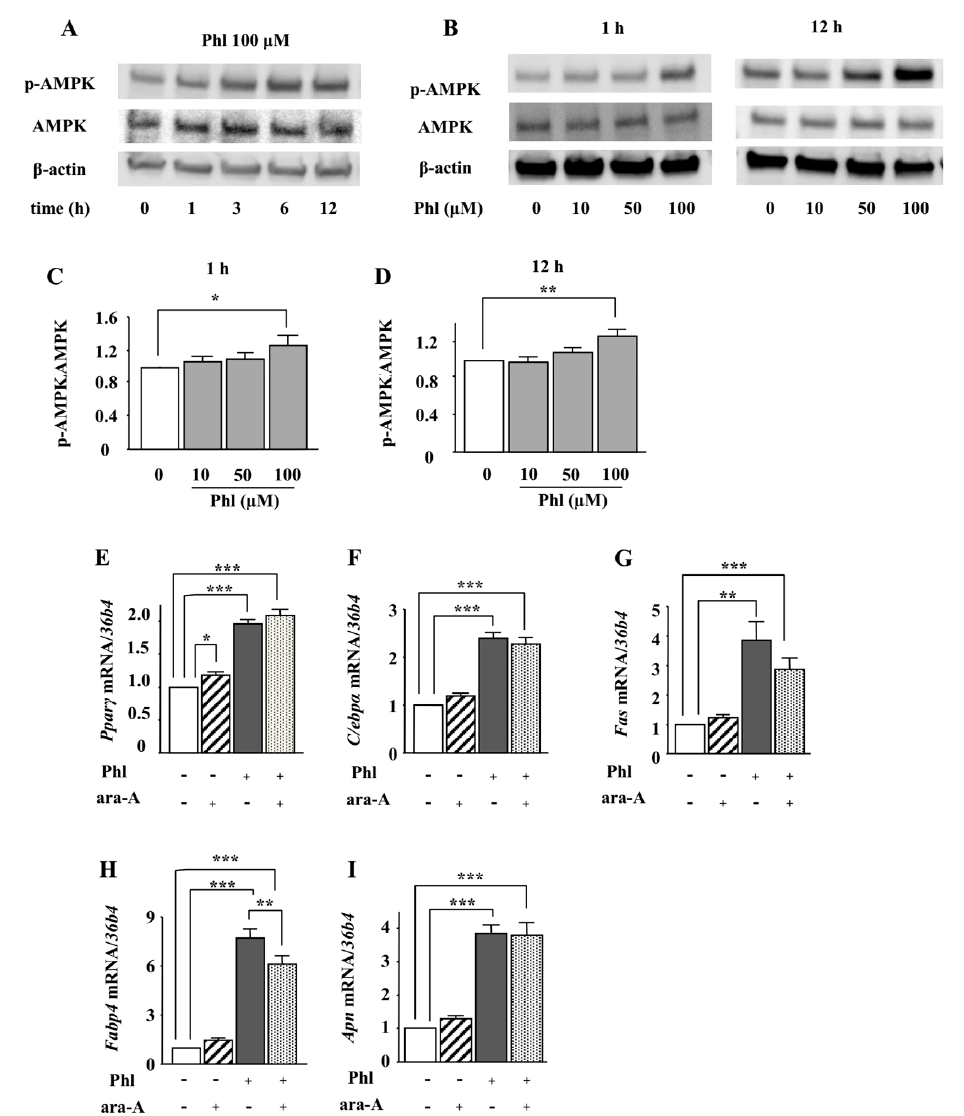
Figure 2. The effects of the AMPK inhibitor ara-A on phloretin-induced upregulation of adipocyte differentiation markers. ( A – D ) After reaching confluency, ST2 cells were incubated in adipogenic medium for 48 h. Thereafter, the cells were treated with 100 µM phloretin for up to 12 h, and western blot analysis was performed to examine the time-dependent effects of phloretin on AMPK ( A ). To test dose dependency, the cells were treated with phloretin (0 to 100 µM) for 1 and 12 h ( B ). Quantification of the bands was performed ( C , D ). The results are representative of at least four experiments. The quantification results are expressed as mean ± SE ( n ≥ 4); * p < 0.05, ** p < 0.01. ( E – I ) After reaching confluency, the cells were incubated in adipogenic medium with 100 µM phloretin and/or 0.1 mM ara-A for 4 days. The mRNA expression of adipogenic differentiation markers ( Ppar γ , C/ebp α , Fas , Fabp4 , and Apn ) was examined by real-time PCR. The results are expressed as mean ± SE ( n ≥ 7); * p < 0.05, ** p < 0.01, *** p < 0.001. Phl: phloretin.